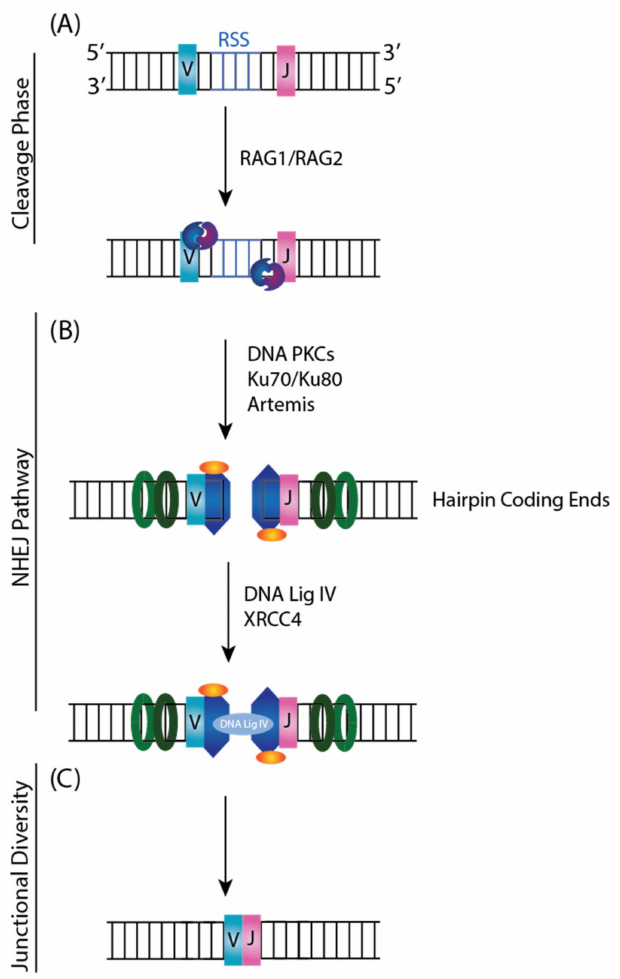
Figure 7. V(D)J Recombination in Lymphocytes and NHEJ. ( A ) RAG1 and RAG2 lymphoid-specific proteins recognize RSS located adjacent to V, D, and J coding segments. RAG1 and RAG2 initiate the cleavage phase and introduce a pair of DSBs between the RSS and the V, D, and J coding segments resulting in hairpin coding ends or blunt phosphorylated ends (not depicted). ( B ) NHEJ machinery will then recognize the hairpin coding end and repair RAG generated breaks to ( C ) create a diverse repertoire of antibodies and antigen